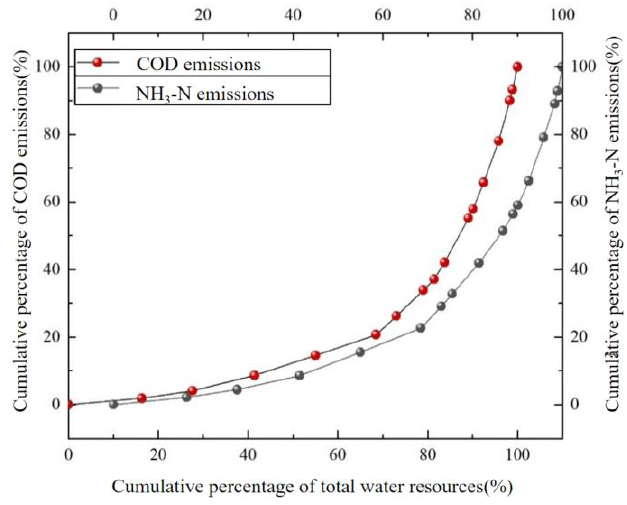
Figure 4. Lorenz curves of COD and NH 3 -N based on GDP indicators.